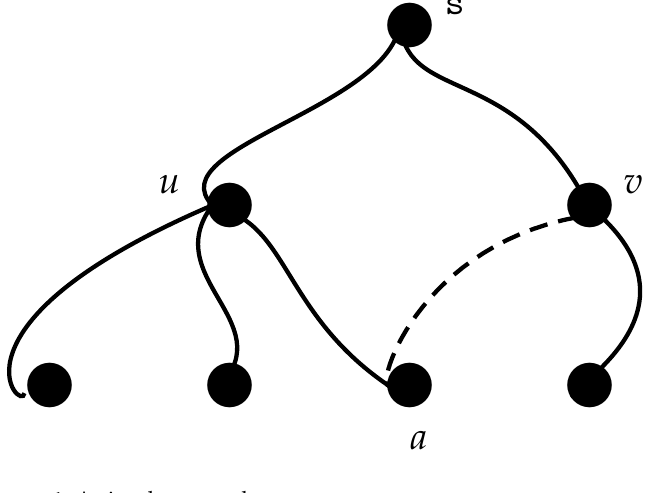
network. Figure 1. A simple Figure 1. A simple